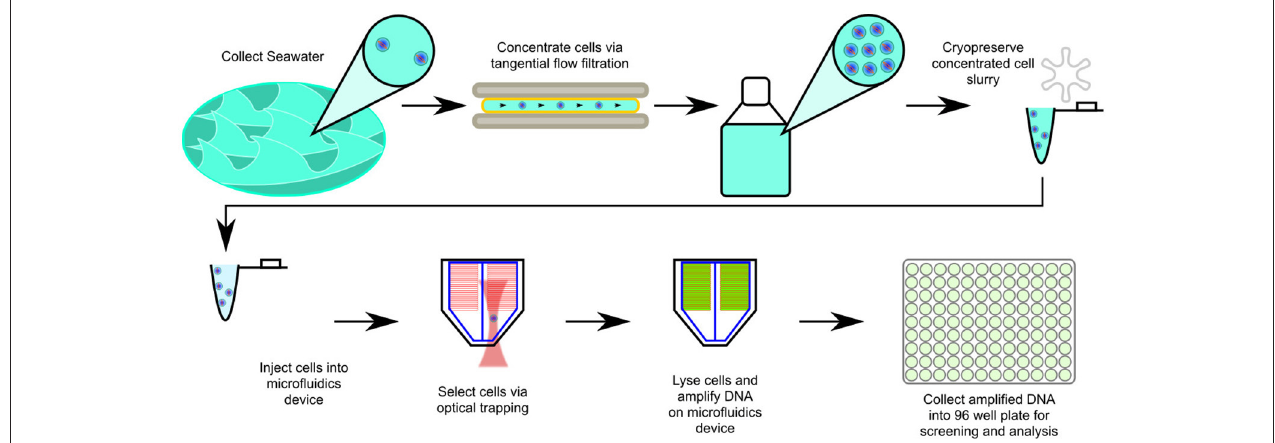
FIGURE 1 | Scheme for optofluidic single cell genome amplification from concentrated marine bacterioplankton samples. In the cell sorts reported here, the operator visually targeted submicron cells. For a more detailed explanation of the technology, please consult (Landry et al., 2013).